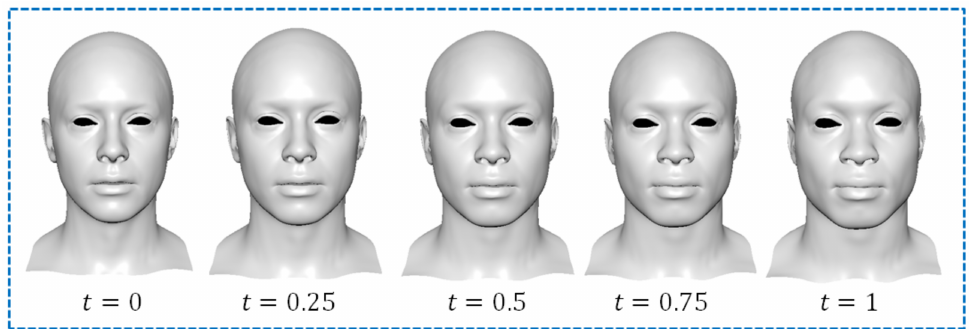
Figure 10. Facial blendshapes created by using Equation (29) with w 1 = 0.2, w 2 = 0.1, and w 3 = 0.7.